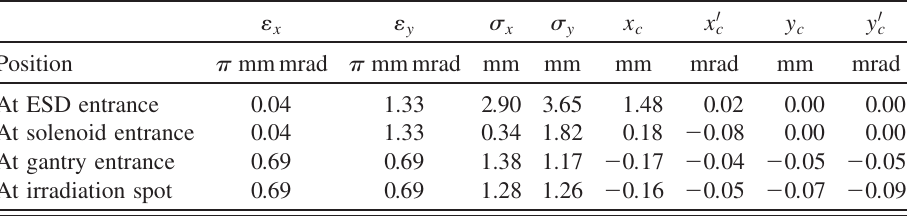
TABLE I. TURTLE simulation conditions and results with the initial distribution in the horizontal phase plane shown in Fig. 1, where " emittance, rms envelopes, and beam centroids. The dispersions are zero at all the locations. The large initial nonzero x correlated. However, the beam centroids become much smaller thanks to the emittance balancing